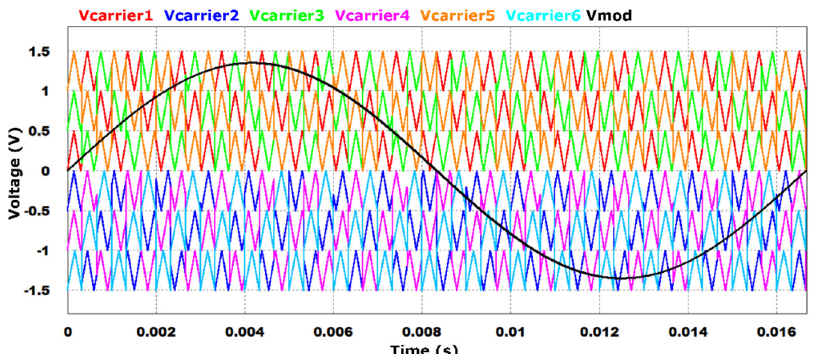
Figure 6. Carrier and modulator signals of the LS PWM modulation strategy, per the modulating signal cycle.